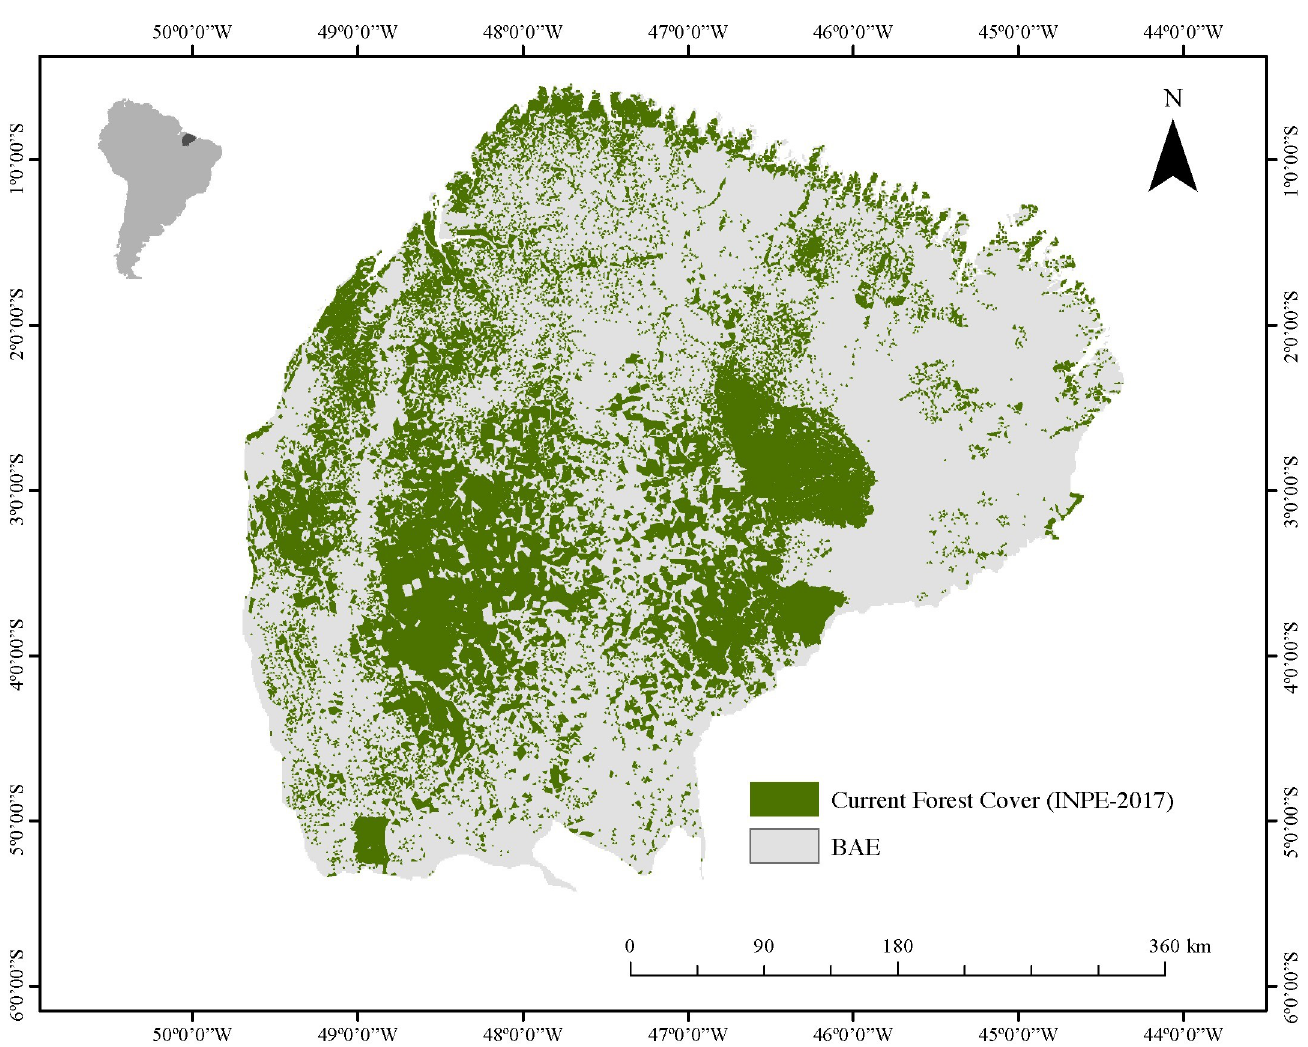
Fig 1. The Be´lem area of endemism. Information on currently forested areas is from the National Institute for Space Research of Brazil (INPE).